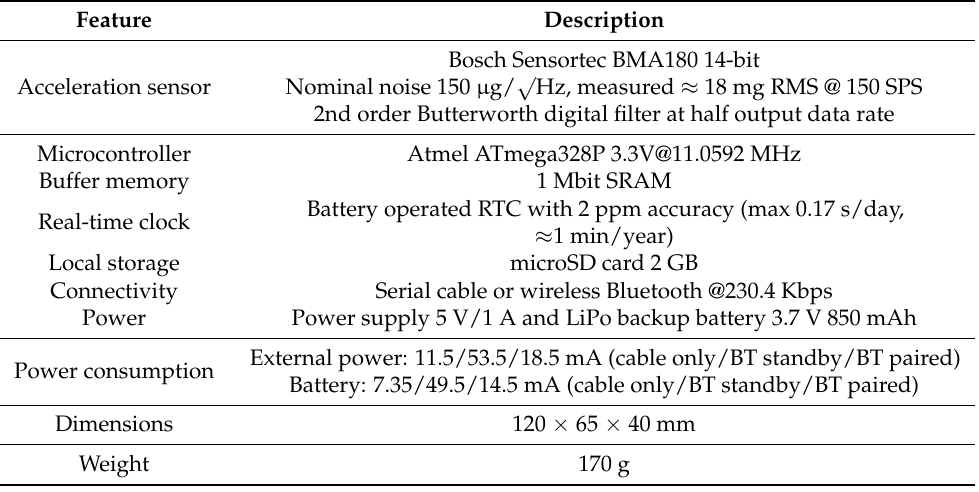
Figure 2. ( a ) Device architecture and ( b ) physical form. Table 1. Device